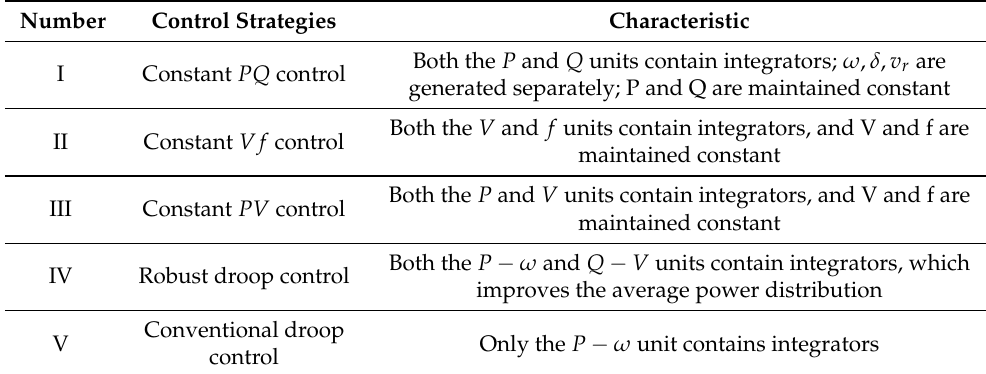
Table 1. Control strategies of inverters and